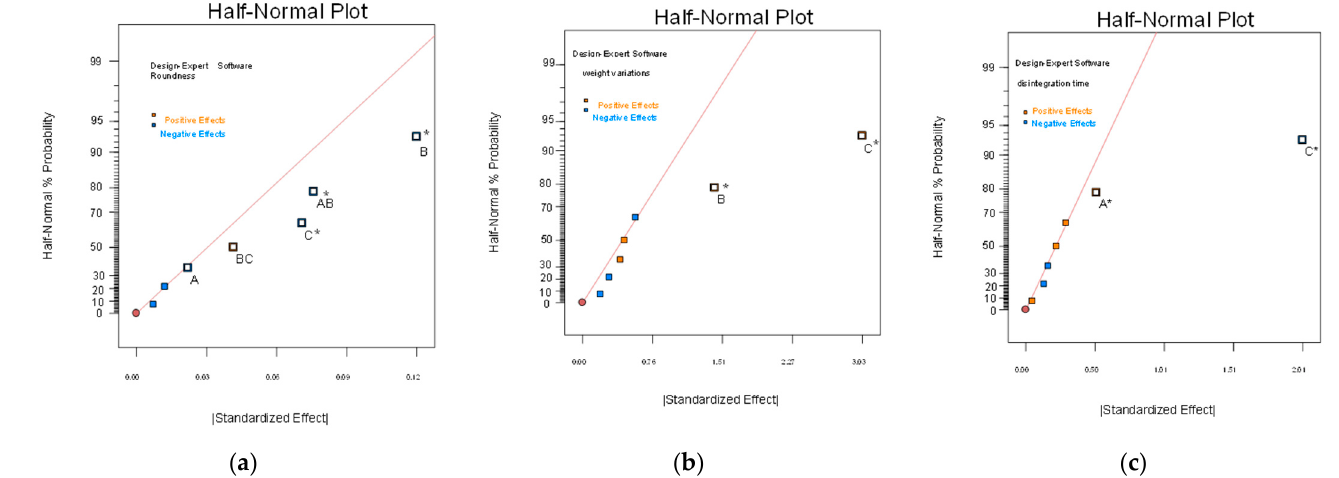
Figure 6. The half-normal plots for identifying significant effects (* p < 0.05). ( a ) The effect on roundness, ( b ) the effect on weight variation, and ( c ) the effect on the disintegration time. The ratio of PEG 4000/PEG 6000 (A), FLL extract loading (B), percentage of Tween 80 (C).